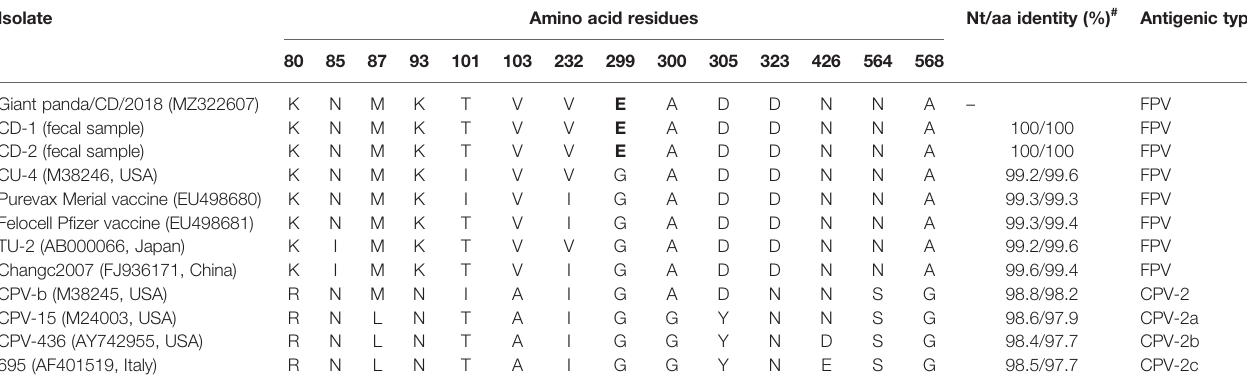
TABLE 1 | Amino acid residue characteristics and pairwise identity in the VP2 protein of giant panda-derived FPV compared with other related parvovirus strains. Isolate Amino acid